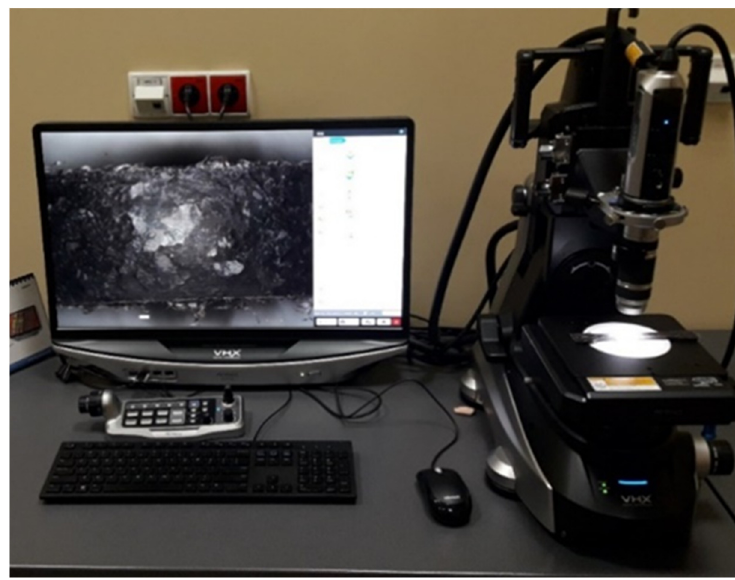
Figure 3. Keyence VHX 7000 confocal microscope.